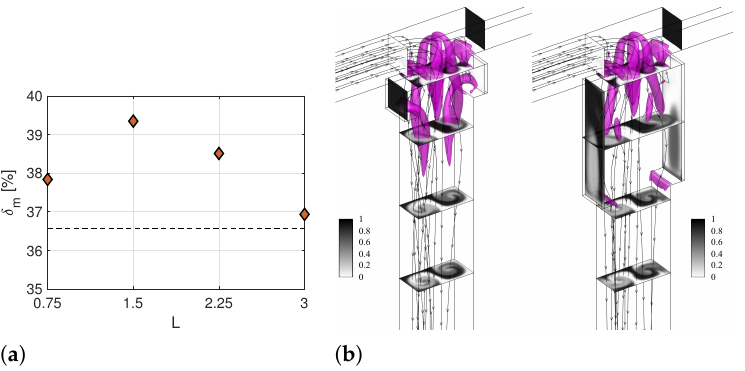
Figure 8. ( a ) Degree of mixing of the T-microchannel with different cavity length ( L ) at Y = − 8. ( b ) Isosurfaces of the λ 2 vortex-indicator and contours of non-dimensional dye concentration at the Y = 0.375, − 1.875, − 3.375, and − 4.874 cross-sections along the outlet channel for geometries with the shortest (left panel) and longest (right panel) length L , i.e., Case L.1 L = 0.75 and Case L.3 L = 3.00, respectively, at Re =